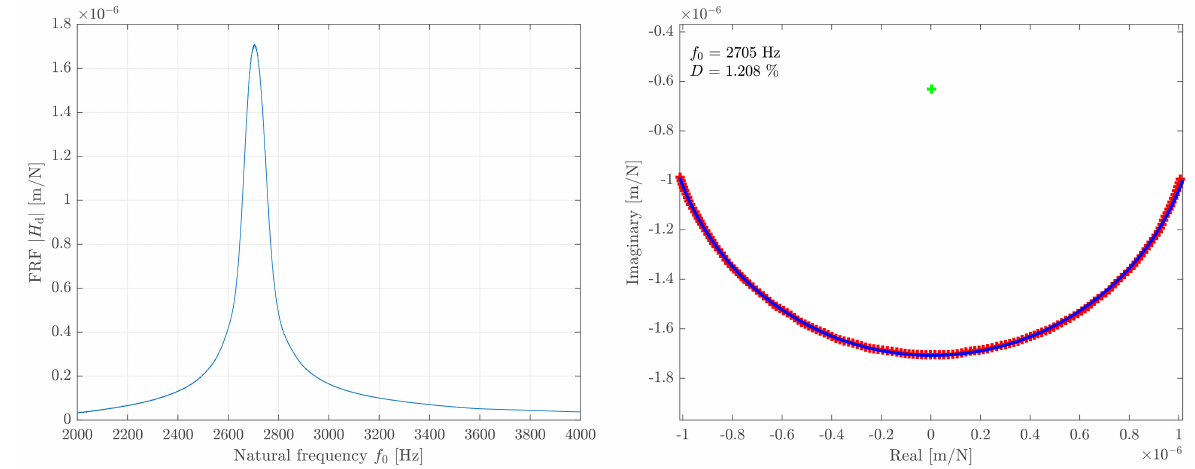
Figure 3. Frequency response function (FRF) left, circle-fit right, reprinted with permission from ref. [7]. Copyright